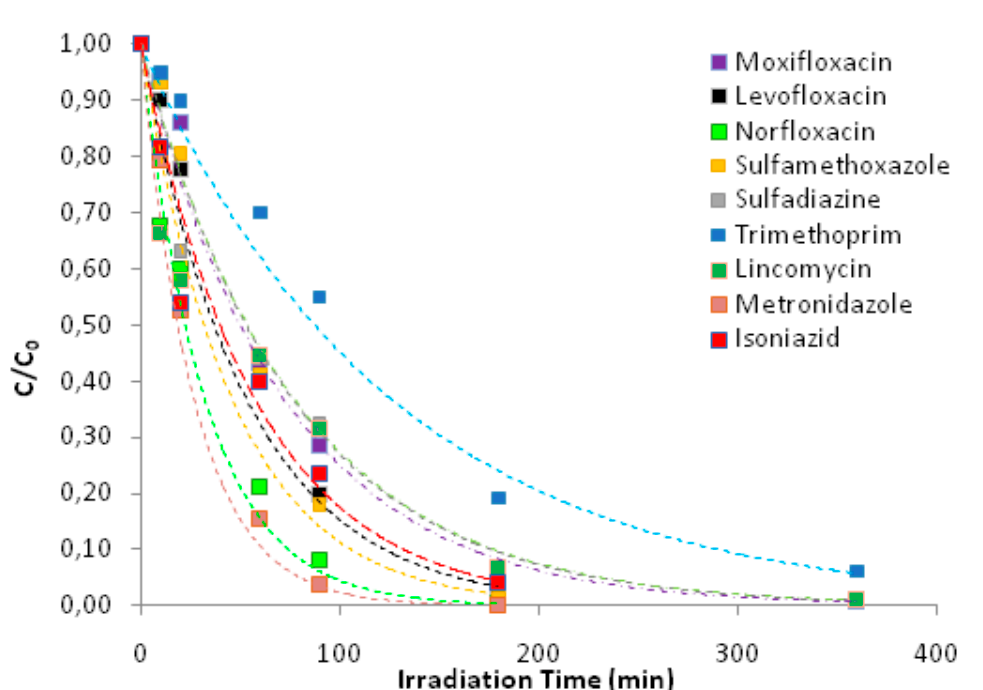
Figure 6. Photocatalytic elimination of the antibiotic mixture with PLLA–GO–50 wt% TiO 2 composite films (C 0(drug) = 1 mgL − 1 , PLLA–GO–50 wt% TiO 2 = 1 gL − 1 , I = 750 Wm 2 ).